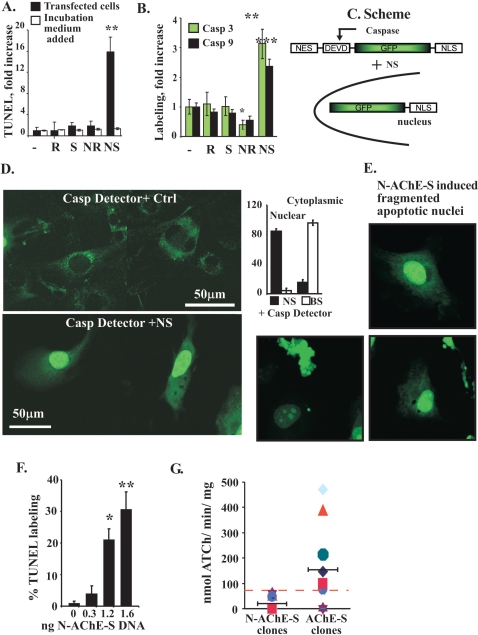
N-AChE-S induces caspase-mediated cell death.A. N-AChE-S mediated apoptosis. TUNEL analysis 24 hr post-transfection in U87MG cells transfected with AChE variants or an “empty” plasmid, compared with non-transfected cells incubated with pre-conditioned medium (*p = 0.001, Student's t test). B. Caspase immunostaining. N-AChE-S-associated increases in activated caspase 3 and 9 and N-AChE-R-associated reduction in caspase 3 in U87MG cells (*p = 0.04, **p = 0.004, ***p = 0.0003 Student's t test). C. Caspase activation reporter. N-AChE-S was co-injected with GFP-NLS vector equipped with NES sequence and a caspase-cleavable DEVD motif. Caspase activation yields nuclear GFP translocation. D. Microinjection-induced caspase-mediated cell death. Micrographs: 3T3 cells co-injected with an “empty” plasmid and GFP-NES/NLS (top micrograph) showed cytoplasmic GFP, whereas N-AChE-S co-injected cells (bottom micrograph) showed nuclear fluorescence (columns). Shown are representative cells, out of N = 70, p<10−7 Student's t test. E. Within 24 hr from injection, cells expressing N-AChE-S acquired nuclei with condensed chromatin. F. N-AChE-S-inducible apoptosis is dose-dependent. Percent of apoptotic U87MG cells under transient transfection with increasing plasmid doses. (*p = 0.03, **p = 0.002 Student's t test). G. Effects of stable transfection on cell viability. CHO cells were co-transfected with either N-AChE-S or AChE-S vectors, and the G-418 antibiotic resistance plasmid, and were grown for 14 days in the presence of G-418. Individual surviving clones were isolated and expanded and cellular AChE activity was measured (p = 0.02, Student's t-test). Note that individual clones transfected with N-AChE-S all showed considerably lower activity, largely below the average activity in human brain extracts (dashed line).